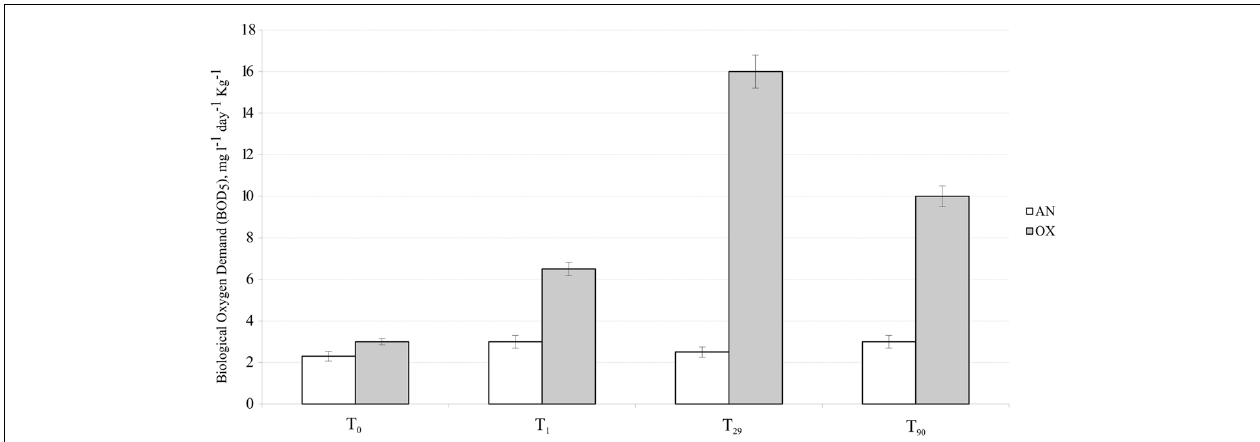
FIGURE 2 | Dynamic of oxygen consumption (BOD values) measured in MSS external (untreated) superficial sediments (white bars) and internal sediments (gray bars). Error bar indicates the standard deviation of triplicate measurements.